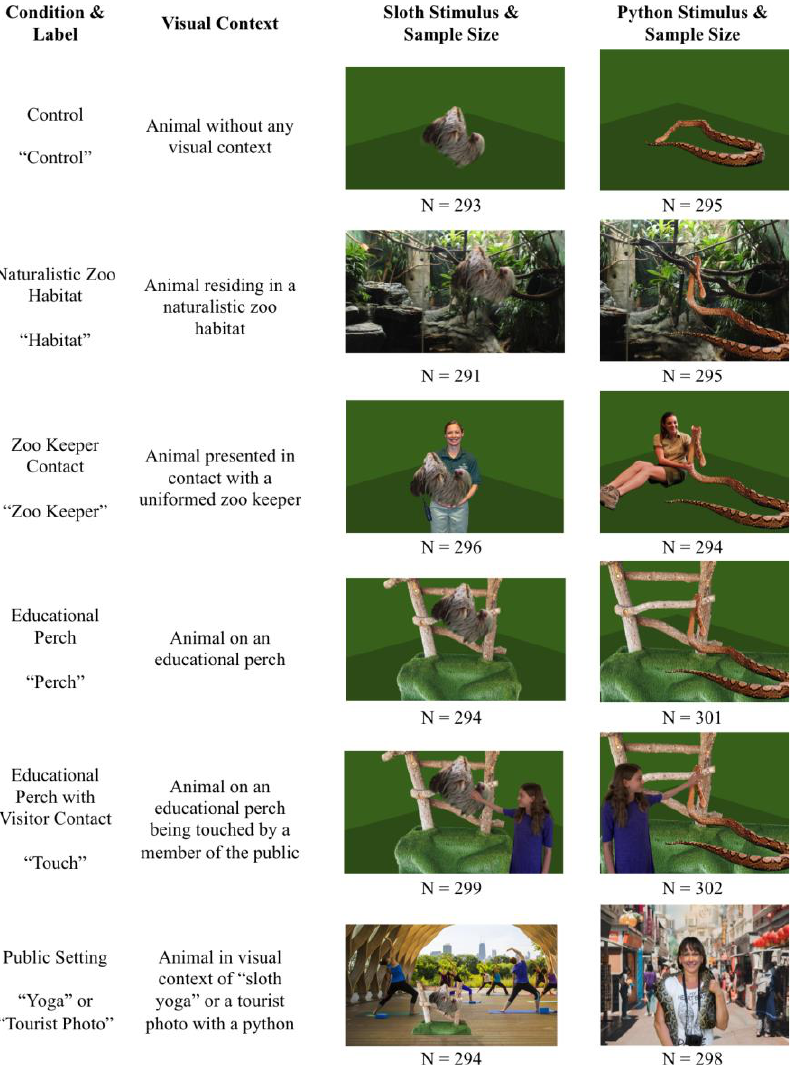
Figure 1. Experimental conditions, survey images, and sample size per condition. Figure reproduced from Cronin et al. [26] with permission under the Creative Commons license.